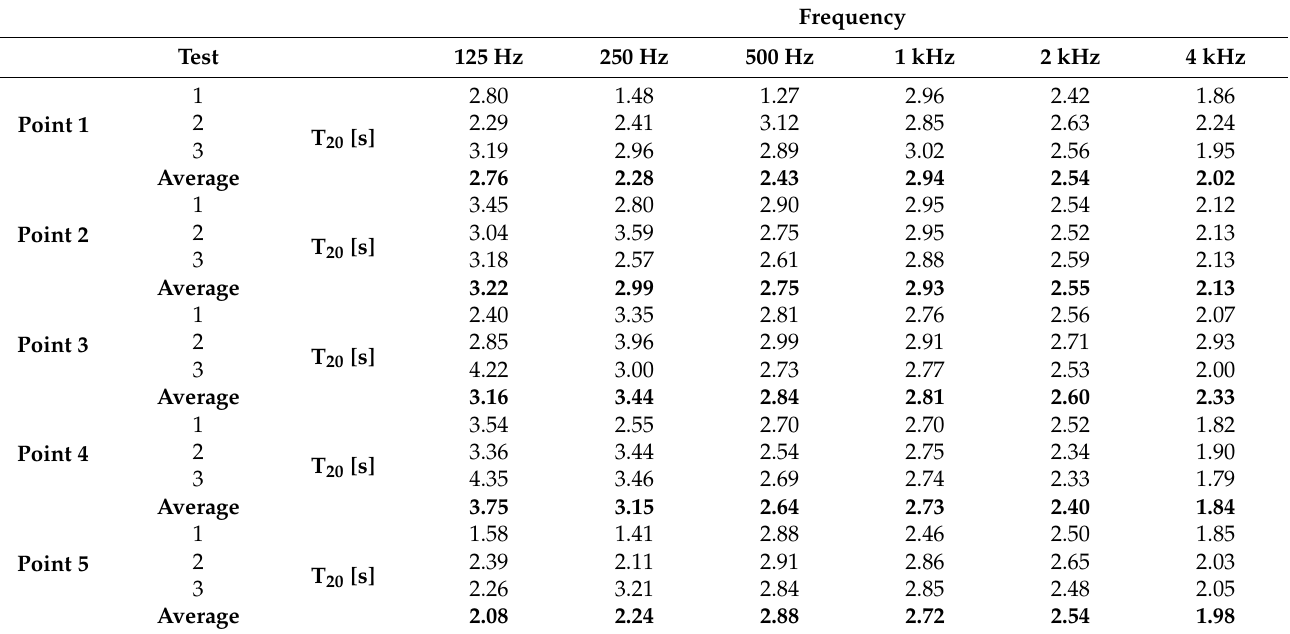
Table 10. On-site measurements: reverberation time (T 20 ) of Combo